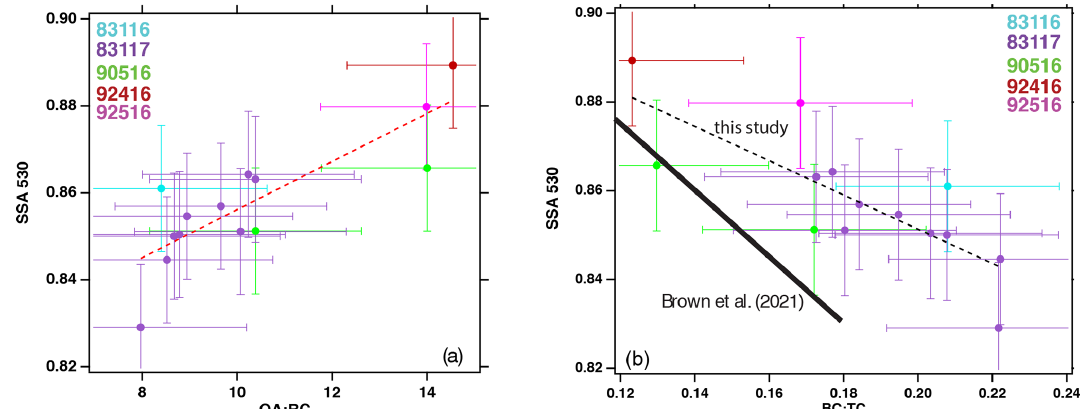
Figure 10. (a) Level-leg mean ± standard deviation values for SSA 530nm versus the OA : BC mass ratio, colored by flight. The best-fit line is represented by SSA = 0 . 801 + 0 . 0055 · (OA : BC) ( r = 0 . 84). Panel (b) is the same as (a) but for SSA 530nm versus the BC : TC mass ratio, where TC = BC + organic carbon. The best-fit line is SSA = 0 . 93 − 0 . 39 · (BC : TC), ( r = − 0 . 79). Times and spatial ranges of the level legs are provided in Table S1. Also shown is the SSA parameterization put forth in Brown et al. (2021), namely SSA 550nm = 0 . 969 − 0 . 779 · (BC :